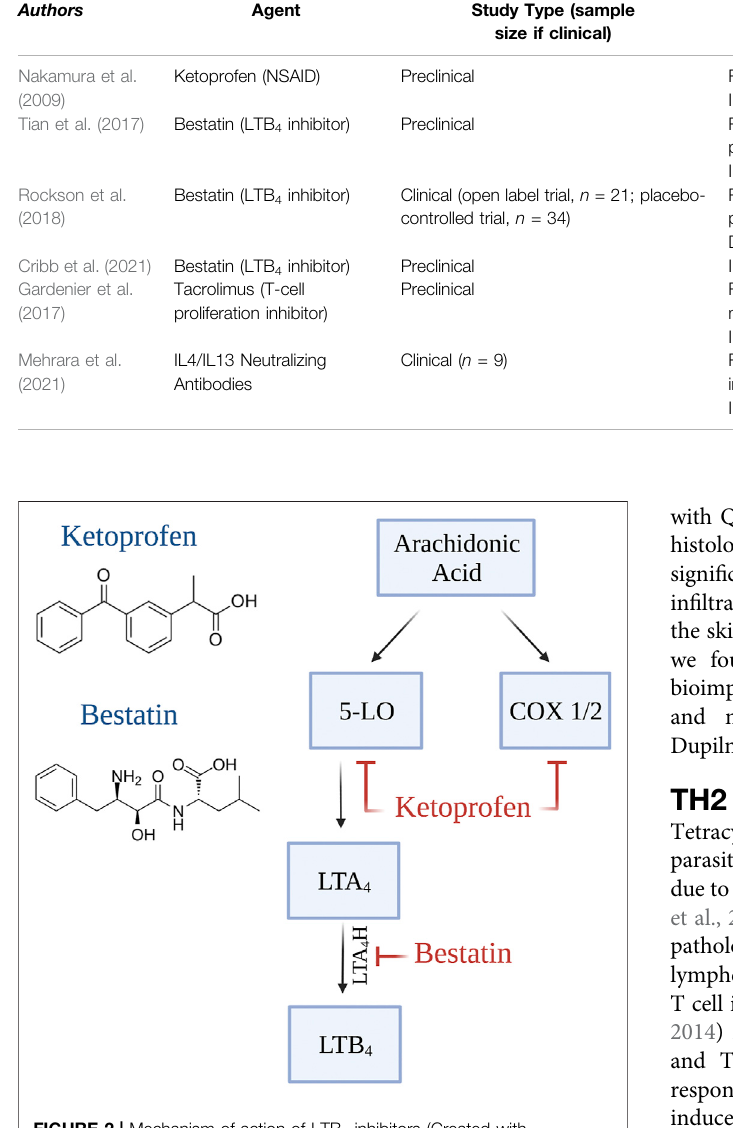
FIGURE 2 | Mechanism of action of LTB 4 inhibitors (Created with